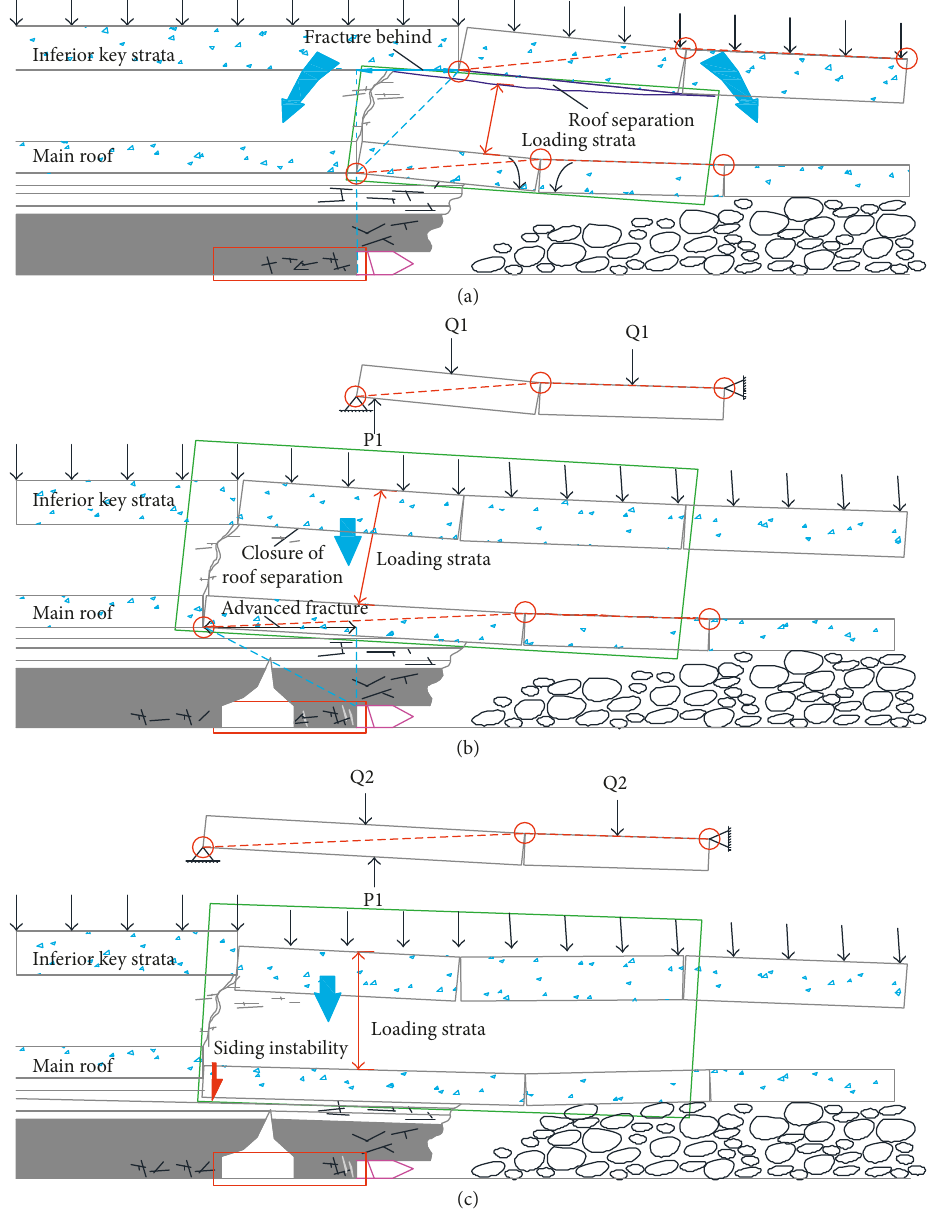
Figure 6: Evolution of the supports crushing